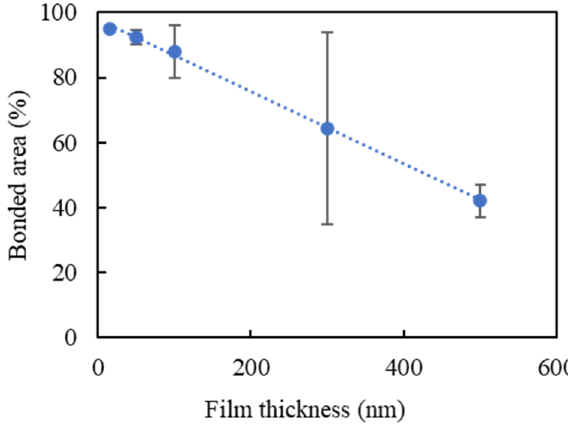
Figure 8. Relationship between bonded area and Au film thickness.